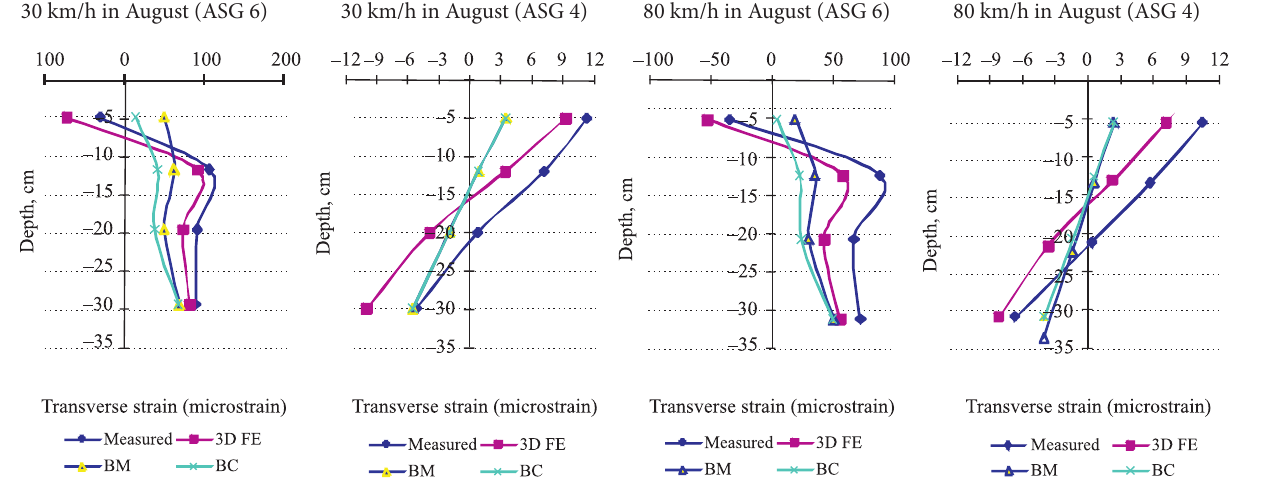
strains30 km/h in August (ASG 6) 30 km/h in August (ASG